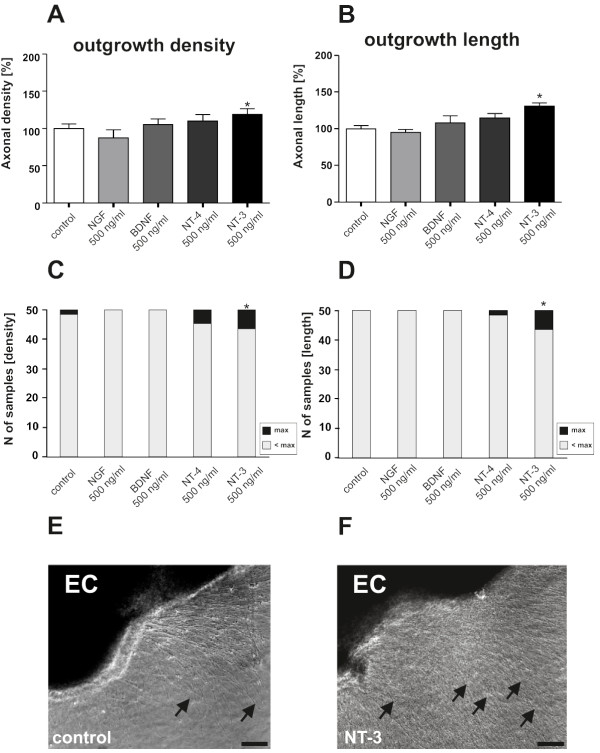
Recombinant NT-3 stimulates neurite density and length of organotypic brain slices. The neurotrophins NGF, BDNF, NT-3 and NT-4 (500 ng/ml) were added to the culture medium immediately after preparation of the organotypic brain slices. NT-3, but not the other neurotrophins significantly increases neurite density (A), neurite length (B), the amount of slices reaching the maximum outgrowth (C) and the amount of slices reaching the maximum length (D). E + F: representative photomicrograph showing the increase in outgrowth of NT-3 treated EC slices compared to control. n = 50 slices. A + B: *: Statistically significant difference to control; p < 0.05 (Mann Whitney U test). C + D: *: Statistically significant difference; p < 0.05 (Chi-square analysis). EC = enthorinal cortex. Arrows indicate outgrowing neuritis. Scale bar: 100 μm.